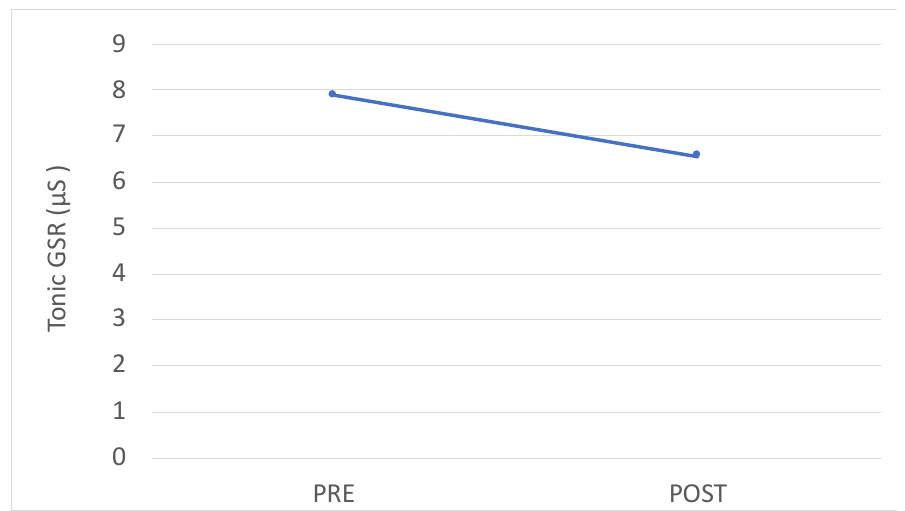
Figure 4. Trend of the features extracted from the R-R series: A ) Root Mean Square of the Successive Differences of the R-R signal (RMSSD), B ) LF/HF ratio, C ) normalized High Frequency component of the ECG signal.